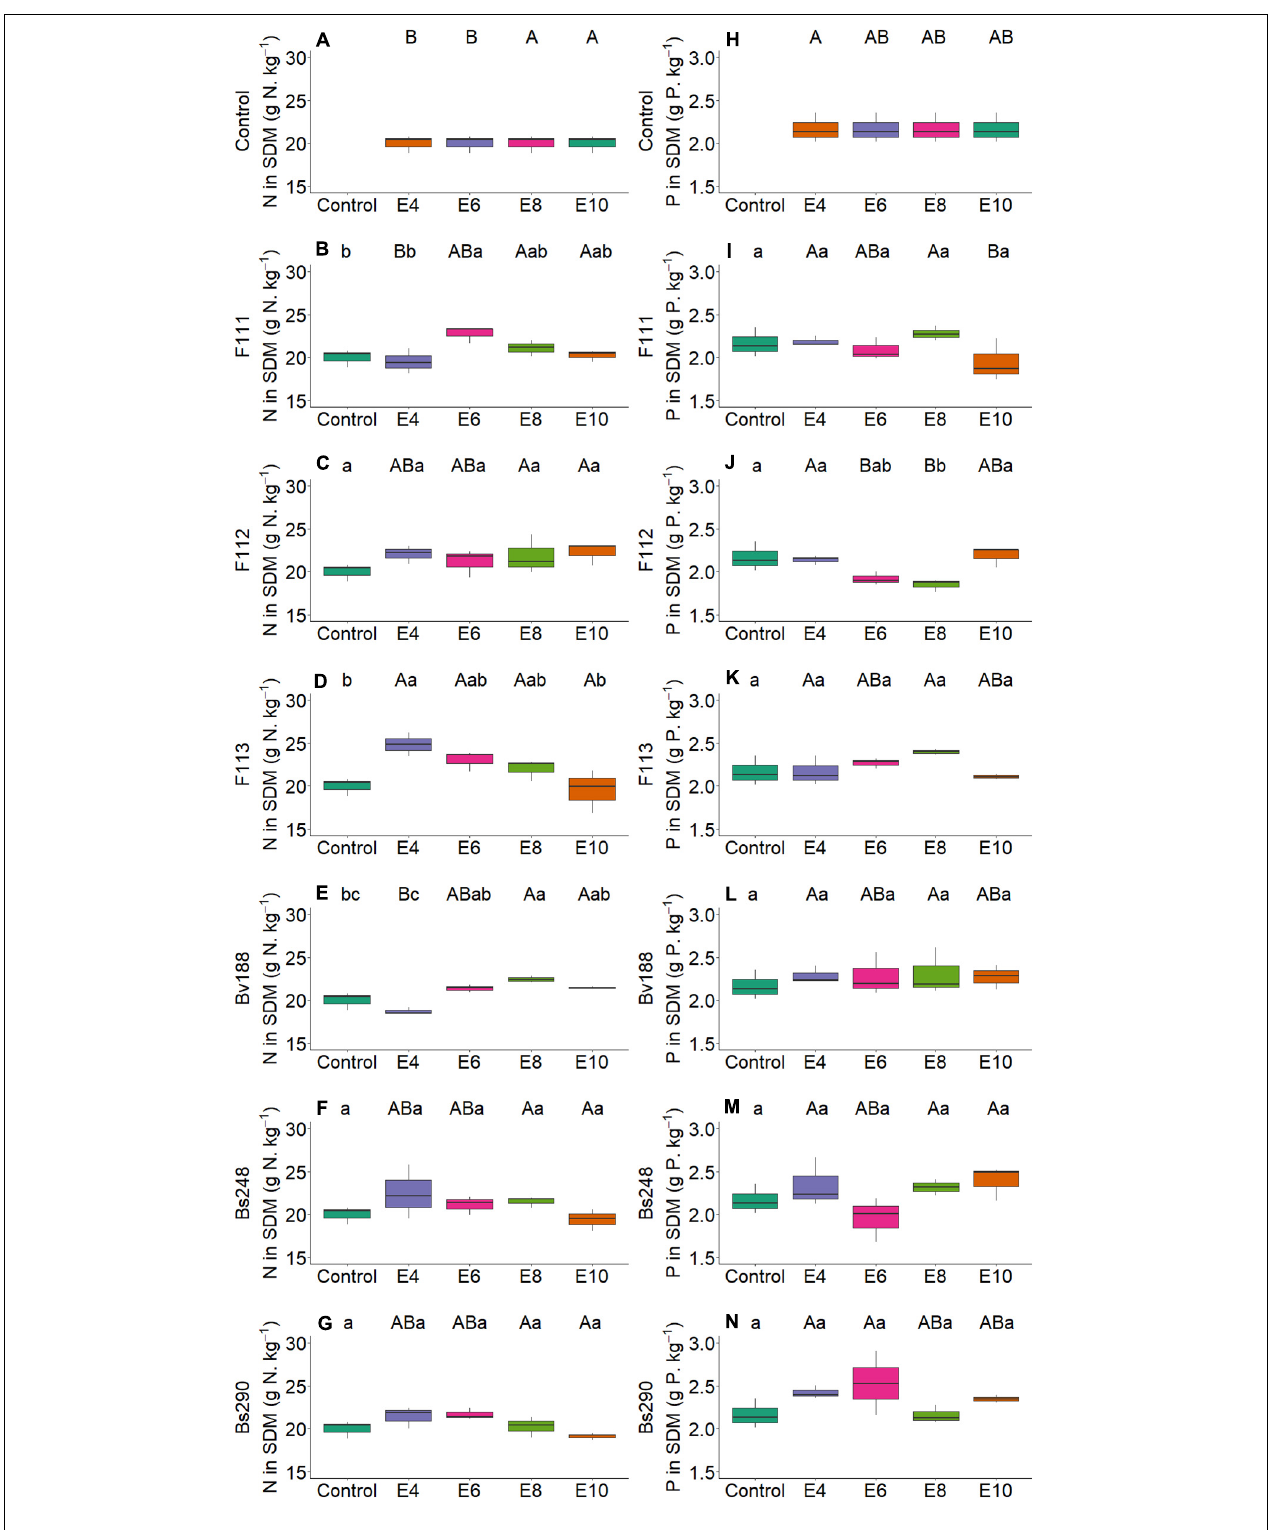
FIGURE 2 | Boxplots (median and quartiles) of nitrogen (A–G) and phosphorus (H–N) content in SDM in cotton inoculated with plant growth-promoting microorganisms. Different lowercase letters in a row and uppercase letters in a column indicate statistical difference between means (Tukey, p < 0.05). F111, Aspergillus brasiliensis ; F112, Aspergillus sydowii ; F113, Aspergillus sp.; Bv188, Bacillus velezensis strain Bv188; Bs248, Bacillus subtilis strain Bs248; Bs290, B. subtilis strain Bs290; E4, 1 × 10 4 ; E6, 1 × 10 6 ; E8, 1 × 10 8 ; E10, 1 × 10 10 conidia or CFU mL − 1 ; Ctrl, control; SDM, shoot dry matter.